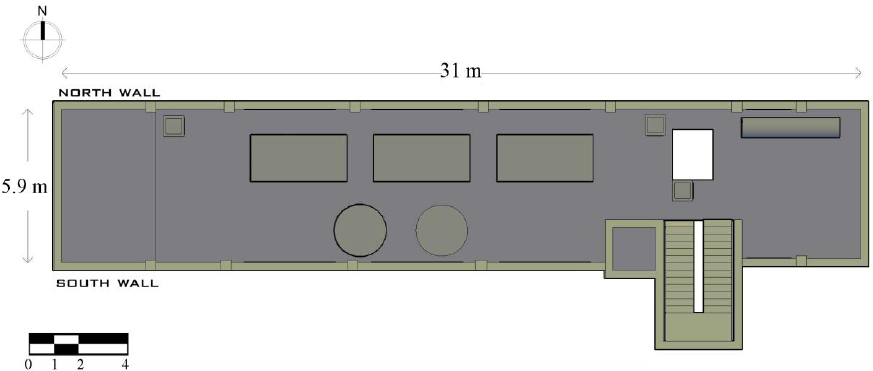
Figure 1. Floor plan of the monitored second floor during the heat treatment.